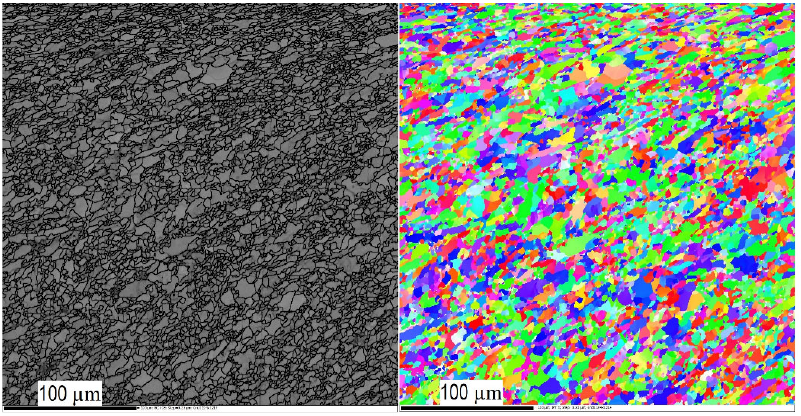
Figure 1. Tested material S700MC—ferritic-bainitic structure. Mechanical properties of the tested material were measured by the static tensile test and results are shown in Table 2. Mechanical properties of the delivered material as YS (Yield Strength), UTS (Ultimate Tensile Strength), A g and A 80 were measured at room temperature—RT. The testing device TIRA Test 2300 (TIRA GmbH, Schalkau, Germany) was used. Static tensile test was performed according to standard EN ISO 6892 ‐ 1 with loading rate 1 mm/min up to achieving YS and after that 15 mm/min. The mechanical properties